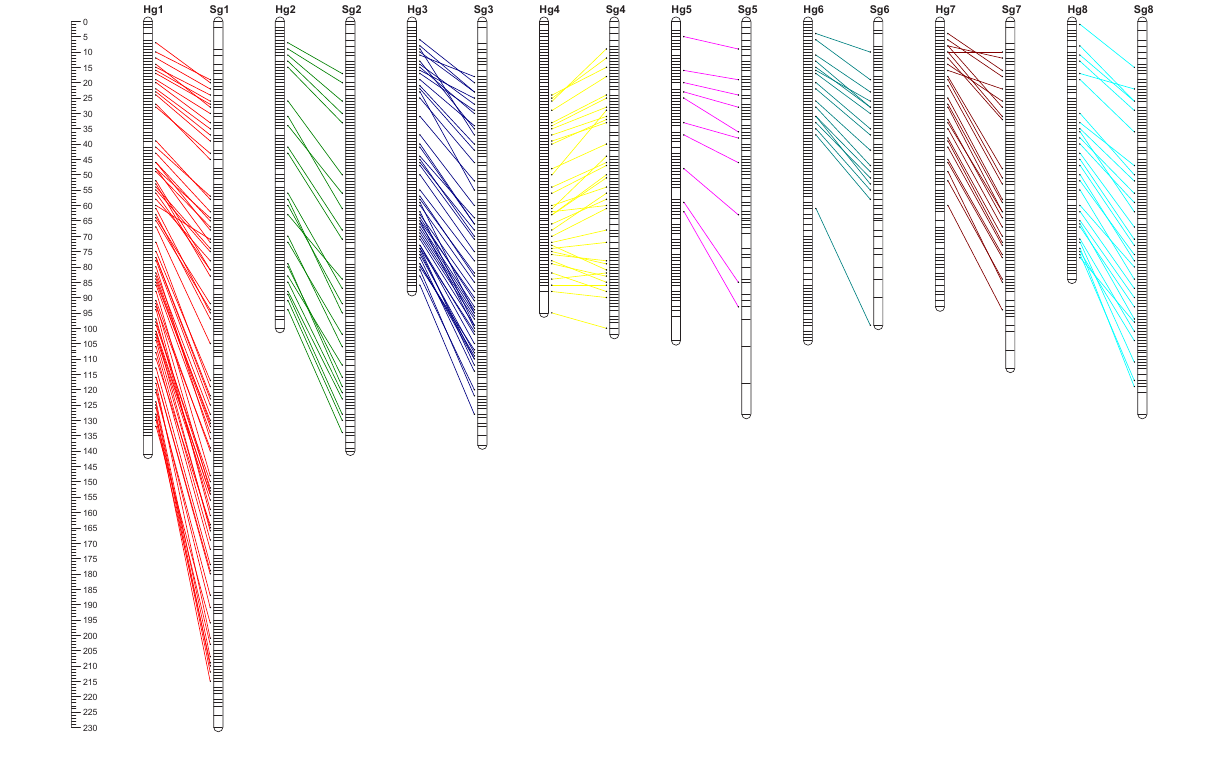
Frontiers in Plant Science |